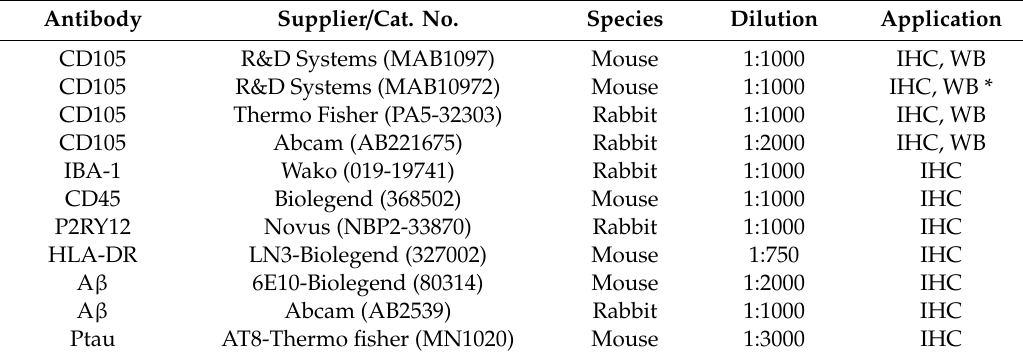
Table 2. Details of antibodies used in